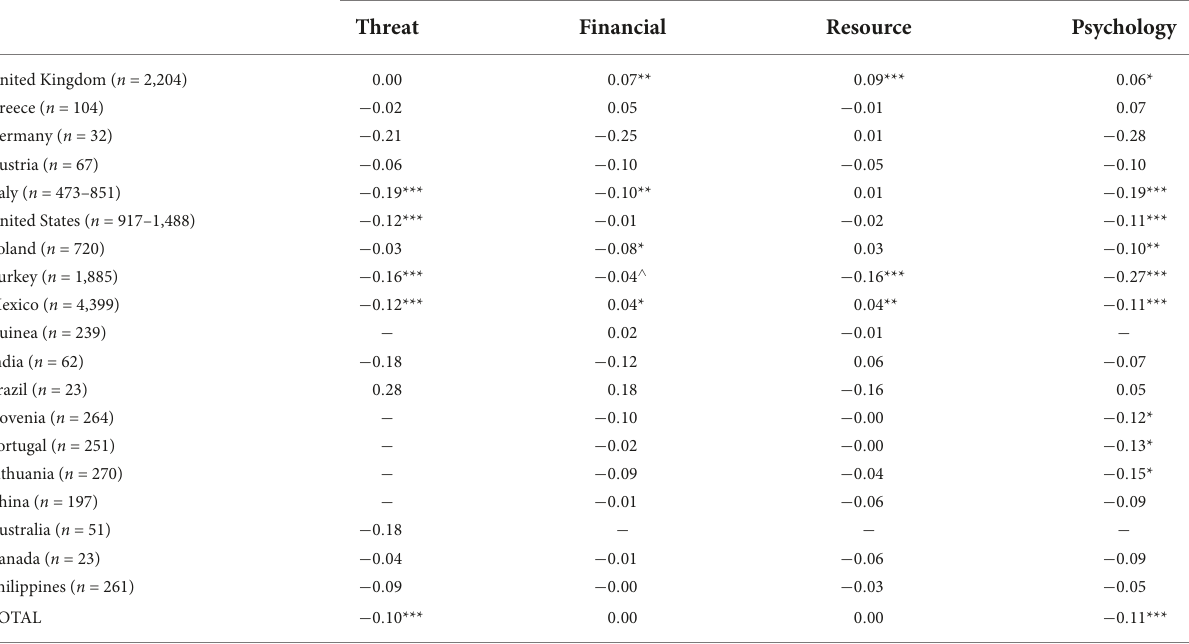
TABLE 4 The relationship of biological sex with perceived COVID threat and impacts across nations. Nation Measure Threat Financial